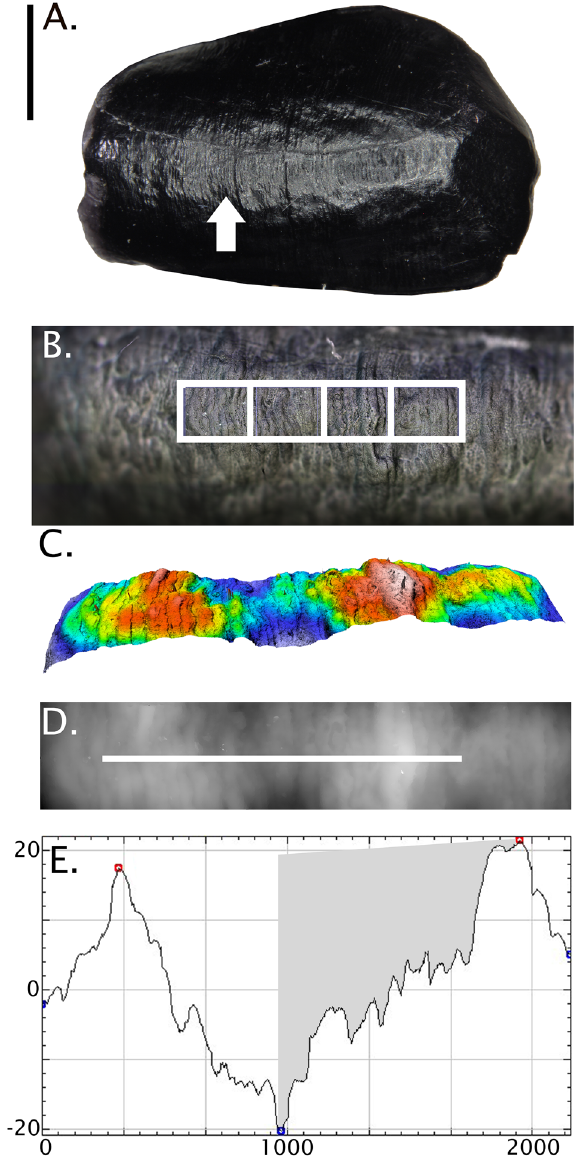
Figure 4. A step-by-step guide to the method. ( A ) Le Moustier 1 LRC epoxy replica with the cusp toward the right of the image (scale = 3 mm). An LEH defect is marked by an arrow. ( B ) An overview image within the SensoSCAN software (S Neox, https ://www.senso far.com/metro logy/produ cts/sneox /) with a bounding box marking the crown region to be scanned. ( C ) The resulting digital elevation model (DEM), showing the defect as a reduction in enamel thickness. ( D ) The DEM is read into ImageJ software 47,48 where a transect is drawn from one occlusal shoulder to the other to extract 2D coordinates for analysis. ( E ) Once plotted, the FindPeaks plug-in 49 is used to measure maximum defect depth from the occlusal side of the defect (in